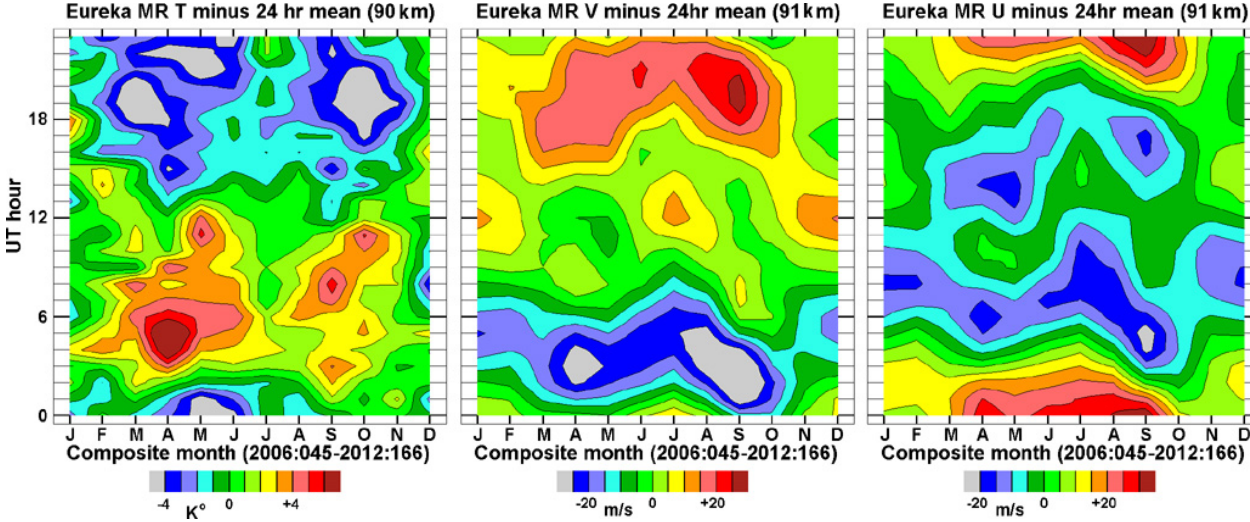
Fig. 10. Monthly (composite year, 2006–2012) diurnal temperature ( T (pressure method), and northward ( V ) and eastward ( U ) wind varia- tions at 90km. The 24h mean has been subtracted from each monthly